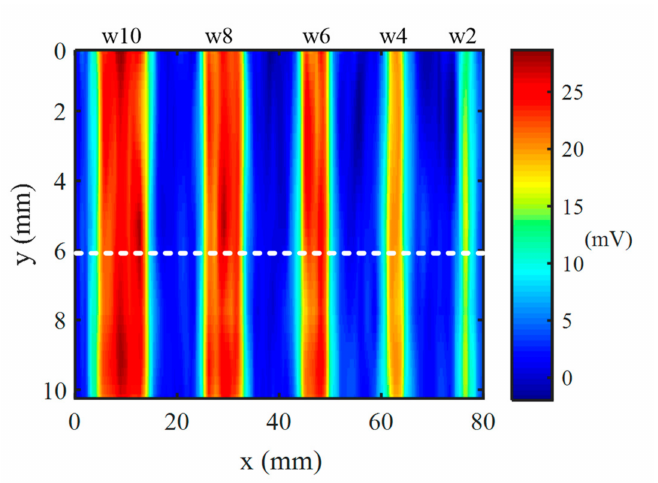
Figure 12. The C-scan image based on reflected transverse waves (2S) from the composite